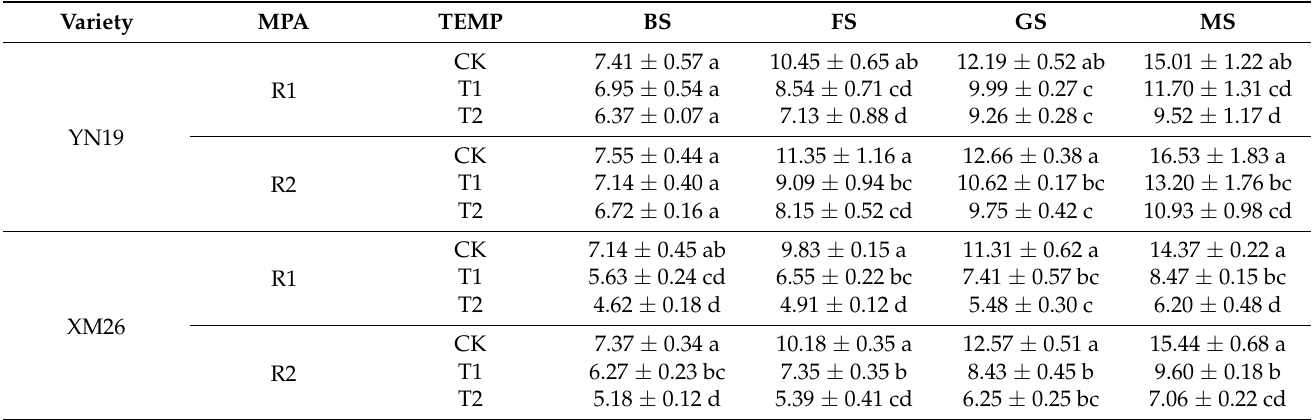
Table 3. Effects of OPA on wheat dry matter accumulation under low-temperature stress at different growth